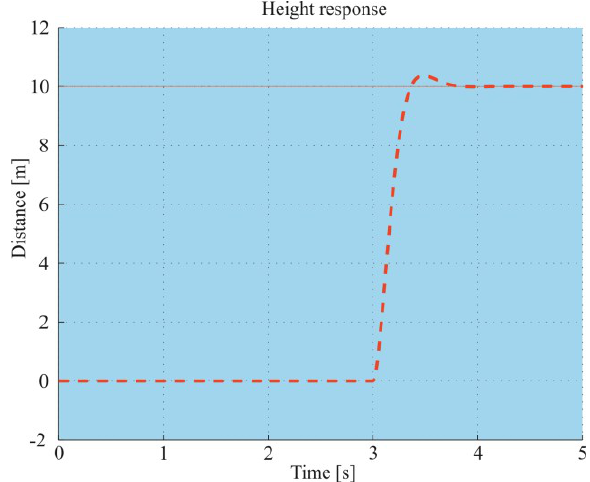
Fig. 7. Angles of the position of the quadcopter in space (PID